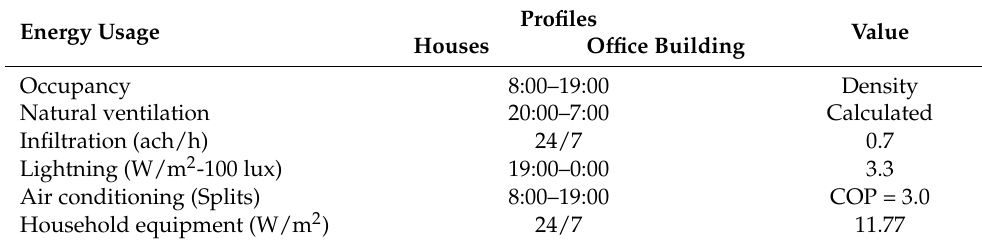
Table 2. Different energy usage profiles in the reference buildings.